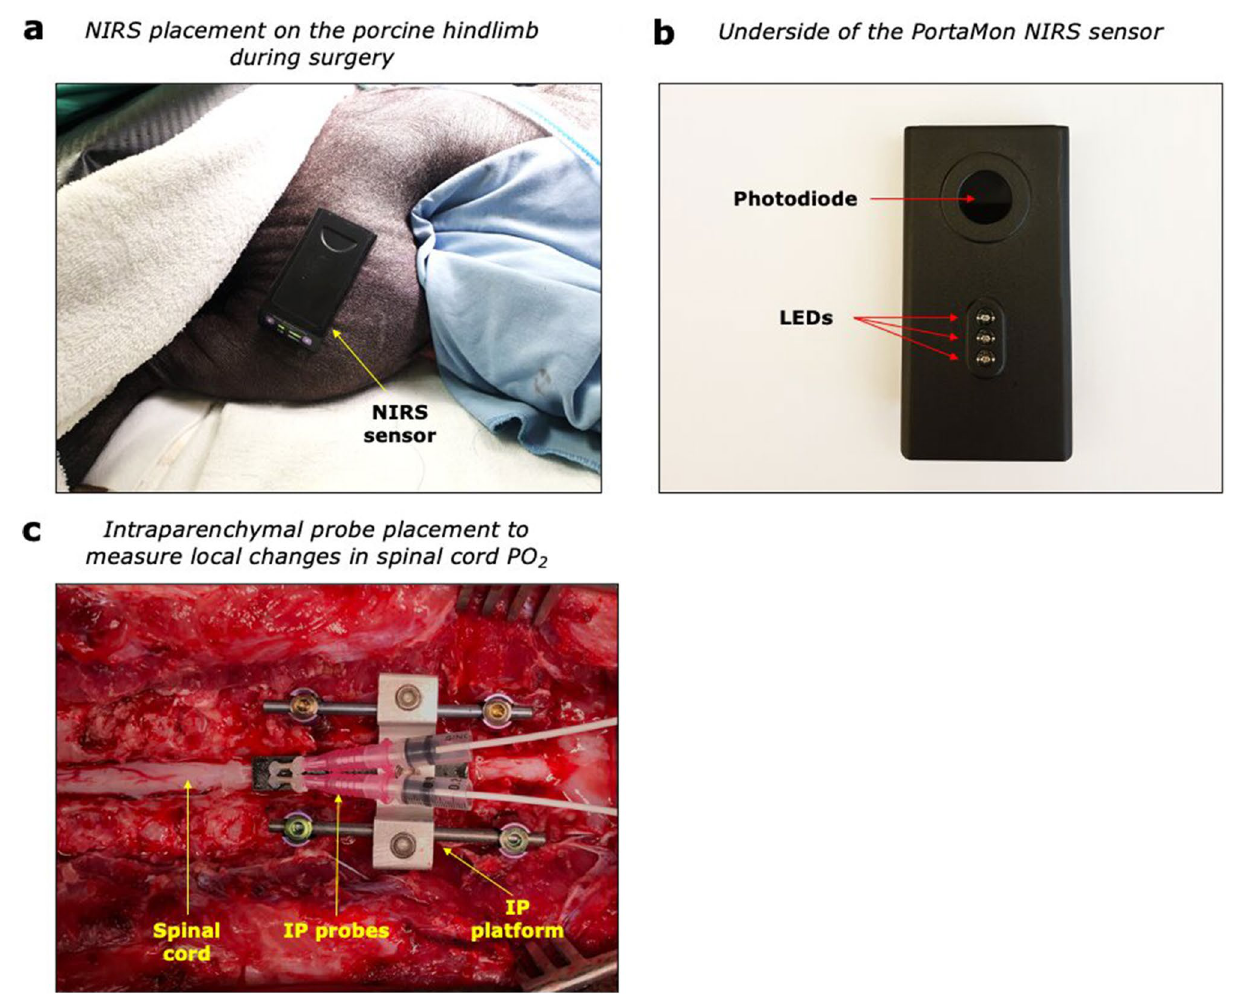
Figure 1. Representative experimental set-up. ( a ) Placement of NIRS sensor (PortaMon, Artinis Medical Systems, The Netherlands) on the left hindlimb muscle of a Yucatan minipig. ( b ) The underside of the NIRS sensor consists of one photodiode (light receiving element) and three LEDs (each transmitting light at two wavelengths; ~ 765 nm and ~ 850 nm). The interoptode distances from the photodiode to each LEDs are as follows: 30 mm, 35 mm and 40 mm. The three LEDs emit a total optical power of 0.88 mW, 1.78 mW and 3.67 mW, respectively. ( c ) Intra-operative placement of spinal cord intraparenchymal (IP) probes to measure local changes in spinal cord PO 2 in response to euthanasia. IP probes were placed as part of other NIRS studies. IP probes intraparenchymal probes, PO 2 partial pressure of oxygen, NIRS near-infrared